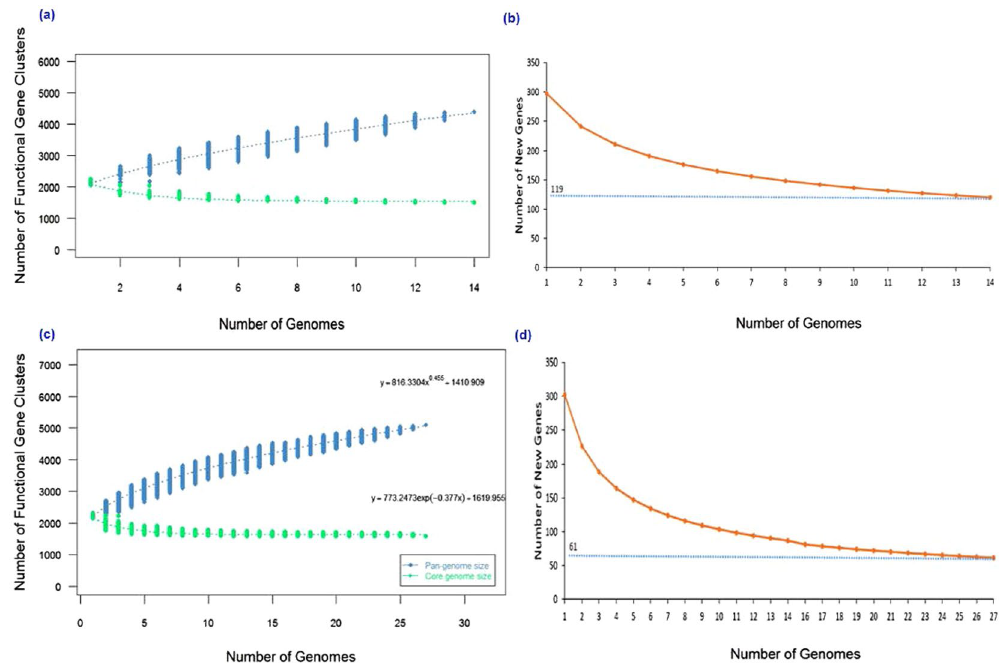
Figure 2. Pan-genome analyses. Curves for Sg ( a ) and Ss ( c ) pan-genomes and core genomes. The blue dots denote the Streptococcus pan-genome size for each genome comparison whereas the green dots indicate the Streptococcus core genome size for each genome comparison. The median values were connected to represent the relationship between number of genomes and gene families. Curves for Sg ( b ) and Ss ( d ) illustrate the number of expected new genes detected with every increase in the number of Streptococcus